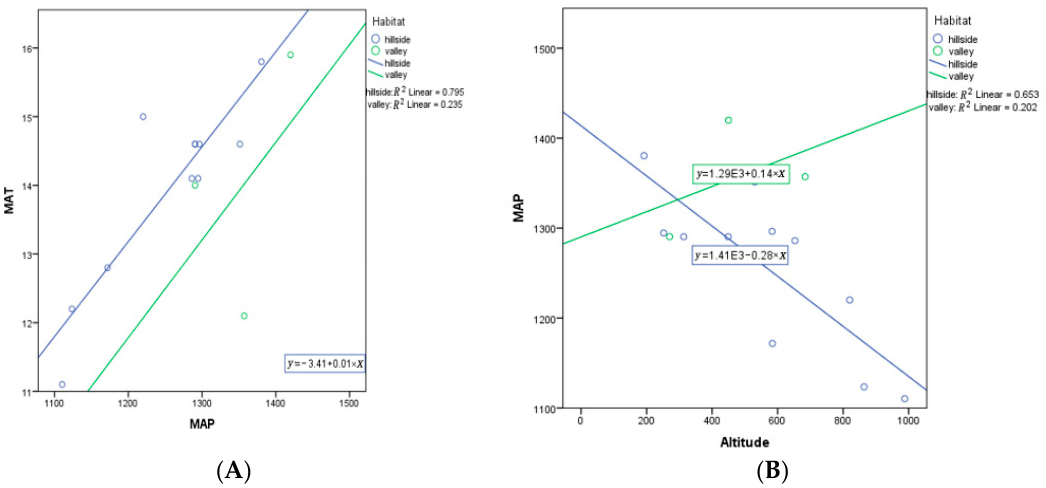
Figure 11. ( A ) ANCOVA between MAP and MAT in different habitats (hillside and valley) ( p = 0.002); ( B ) ANCOVA between altitude and MAP in different habitats (hillside and valley) ( p = 0.009). Each dot represents a sampling site in China. E represent ten to the power of N.